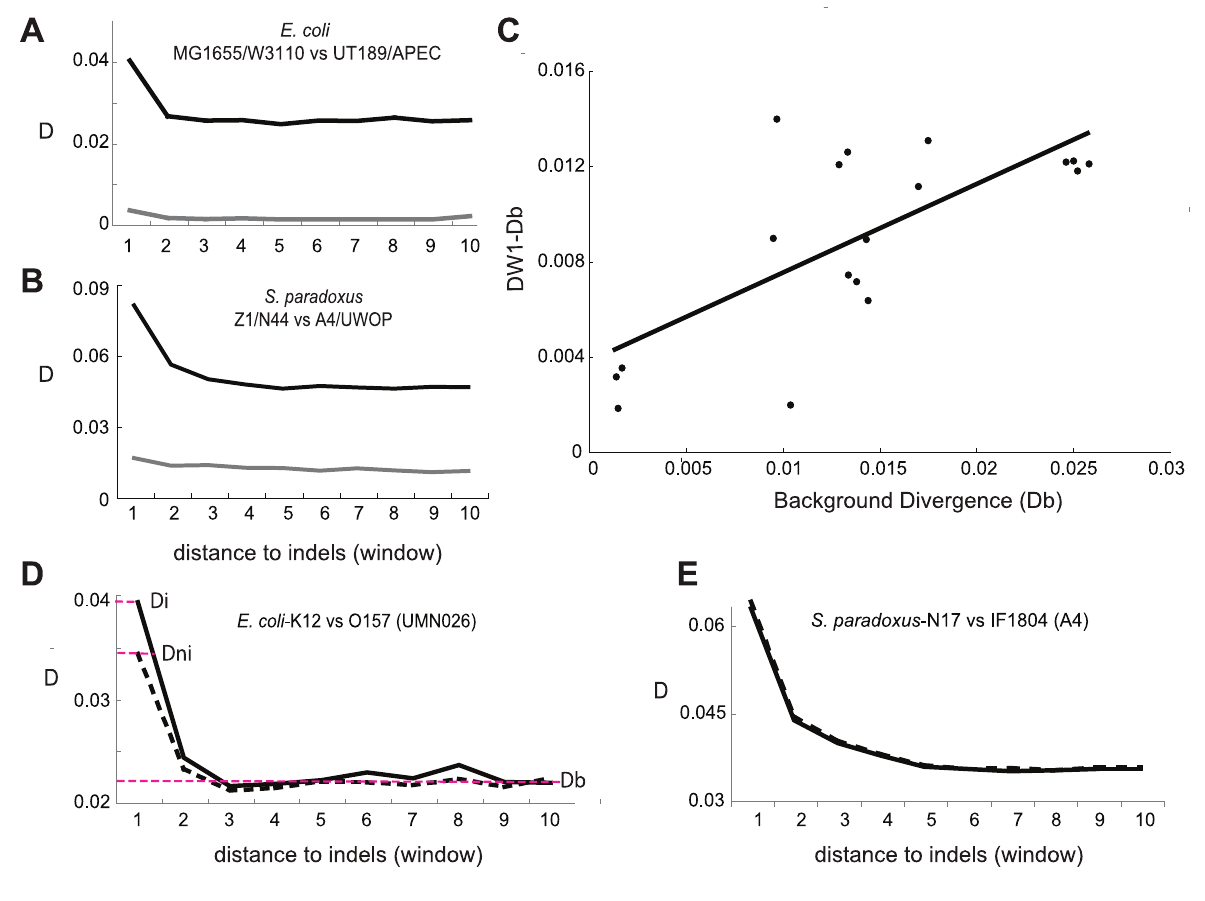
Figure 3. Indel-associated nucleotide substitutions accumulate over evolutionary time scales. Old indels (black) have accumulated a higher D than new indels (grey) in both E. coli (A) and S. paradoxus (B) (see Materials and Methods). (C) The indel-associated divergence (DW1-Db) is plotted against relatedness-associated divergence (Db) (as calculated for Table S4). DW1 is D of the window closest to the indel. Linear regression shows a significant correlation between background divergence (Db) and the value of DW1-Db (Pearson’s correlation coefficient, r =0.711, p =0.00092). (D and E) Both indel and non-indel haplotypes have elevated D close to the indel containing site. Regions of indel haplotypes (solid lines) often have a higher value of D than regions of non-indel haplotypes (dashed lines) in sequence window 1, although this is never significant (two-sample Kolmogorov-Smirnov test, p . 0.05, Table S2). (D) The analyses performed in E. coli and (E) the analyses performed in S. paradoxus . The strain used as the outgroup in each comparison is shown in parentheses. The total nucleotide diversity can be divided into fractions attributable to the indel + region effect (Di), the region (non-indel) effect (Dni), or the background level divergence of the two aligned orthologous fragments (Db) (red dashed lines in panel